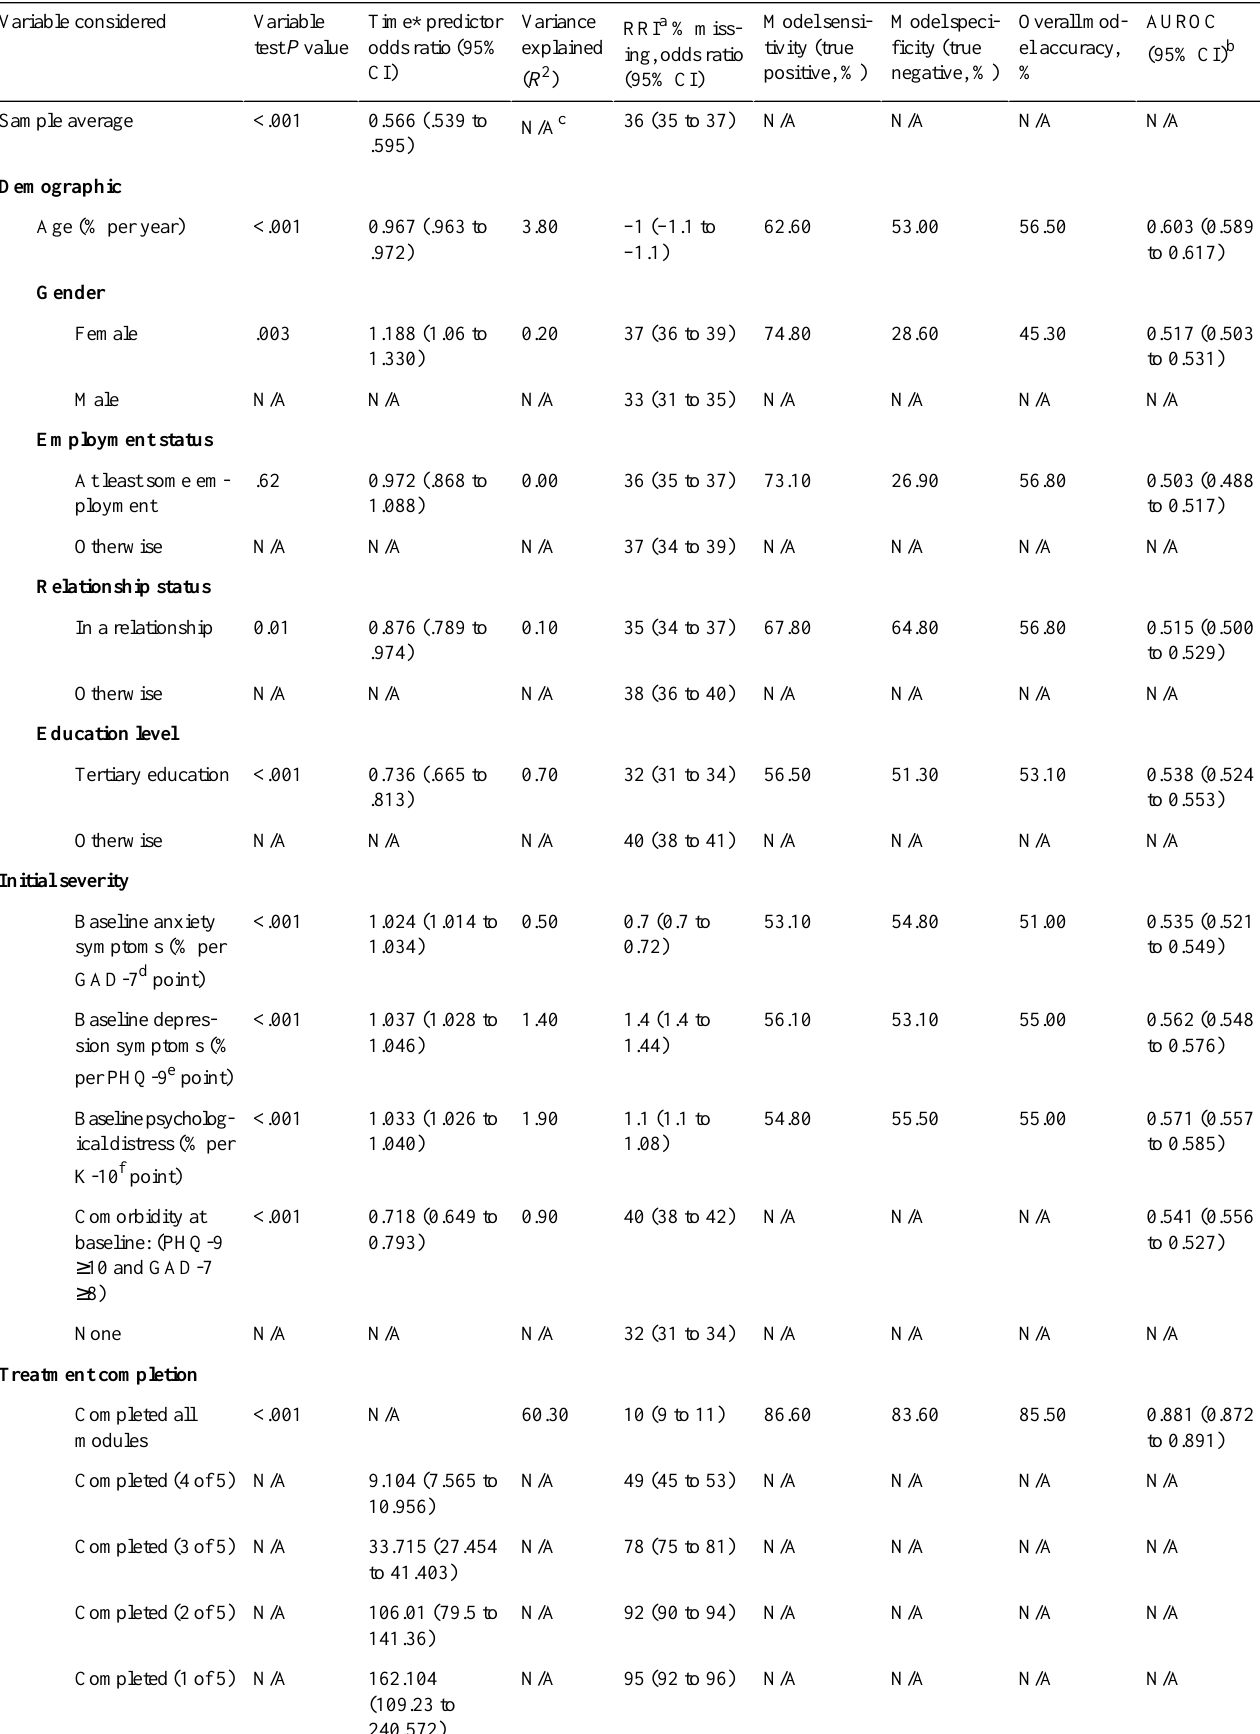
Table 3. Univariate missing cases probability models of the total sample